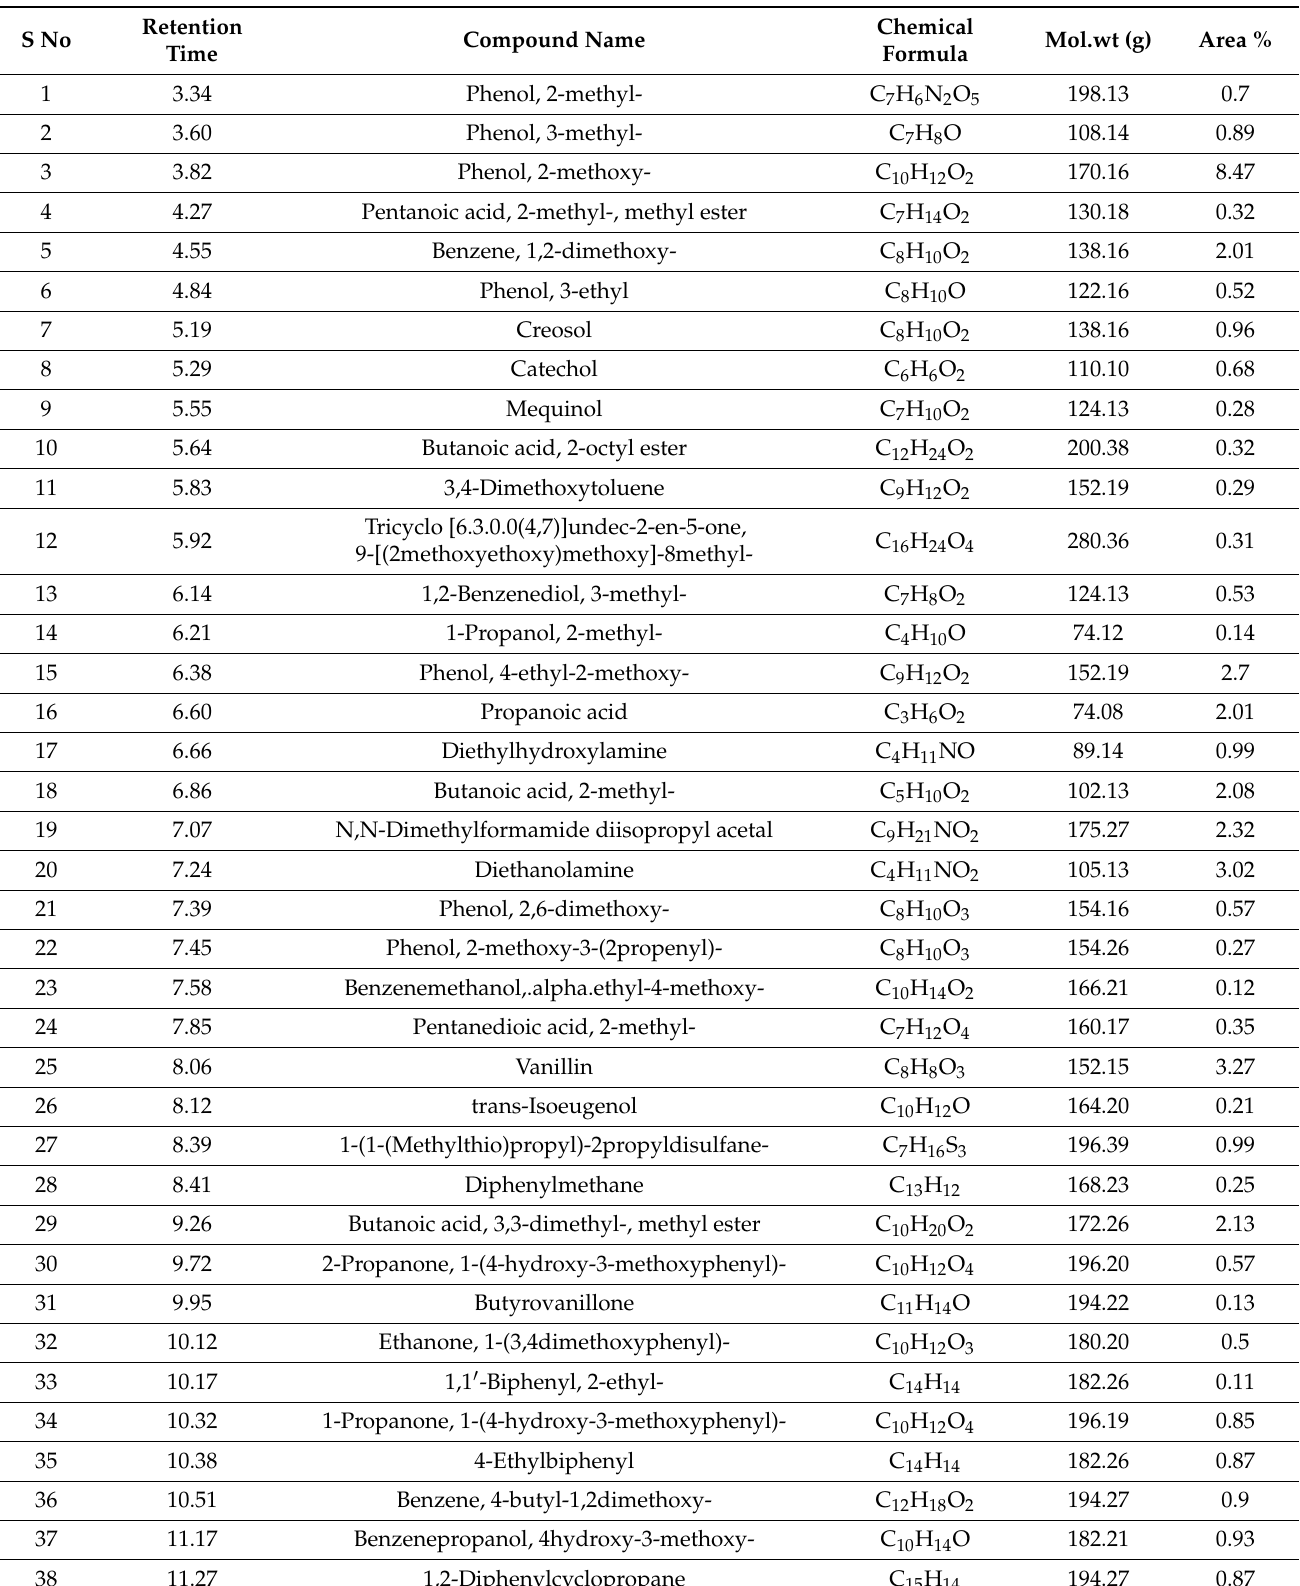
Table 2. Composition of bio-oil collected from lignin pyrolysis in the absence of